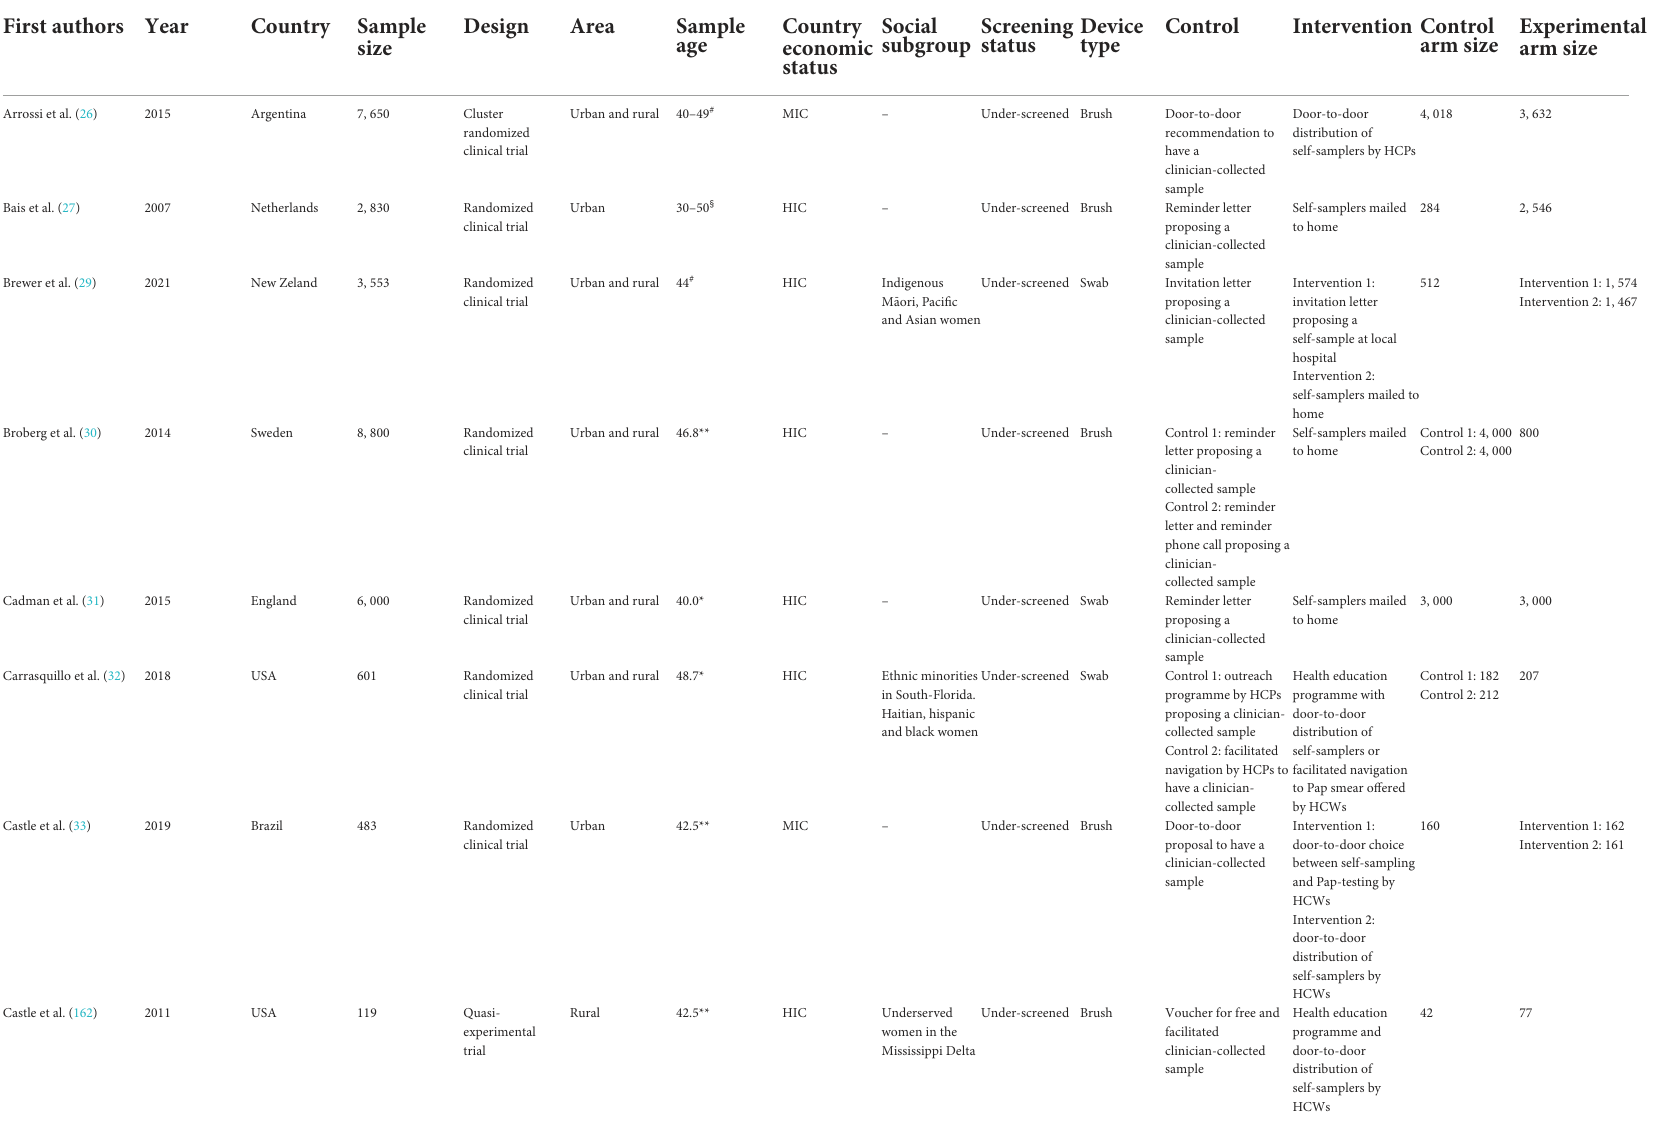
TABLE 3 Characteristics of the included studies assessing cervical cancer screening (CCS) uptake comparing self-sampling with clinician-collected samples for HPV